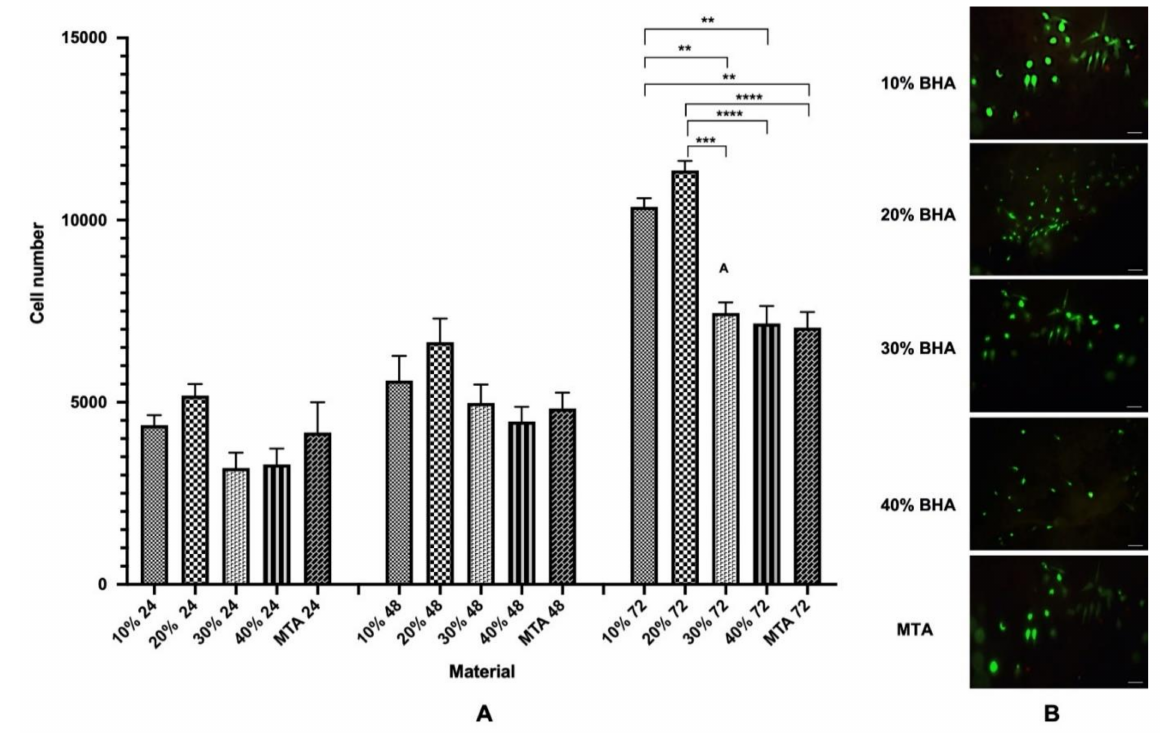
Figure 7. ( A ) Proliferation (MTS assay) of Saos-2 cells after seeding onto BHA cements and MTA after 24, 48 and 72 h. Error bars represent ± SE of the mean after 1-way ANOVA with Tukey’s multiple comparison test (n = 3, ** p < 0.01, *** p < 0.001, **** p < 0.0001 and error bars represent the SE of the mean). ( B ) Fluorescent images showing cell viability of Saos-2 cells seeded on the BHA cements and MTA discs after 48 h (n = 3). Green = live cells (calcein), Red = dead cells (ethidium homodimer-1). Scale bar = 100 µ